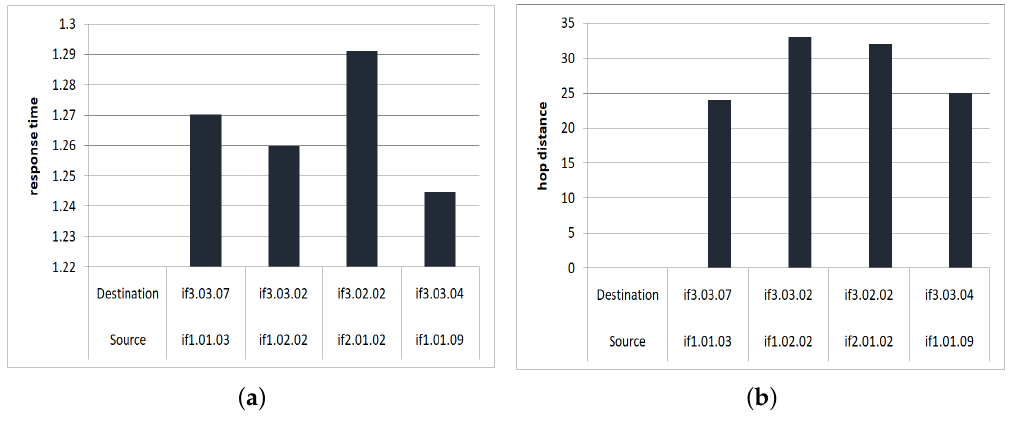
Figure 16. Performance of routing between two cells in four cases in different buildings and different floors. ( a ) Response time performance; ( b ) the distance of hops in different buildings and different